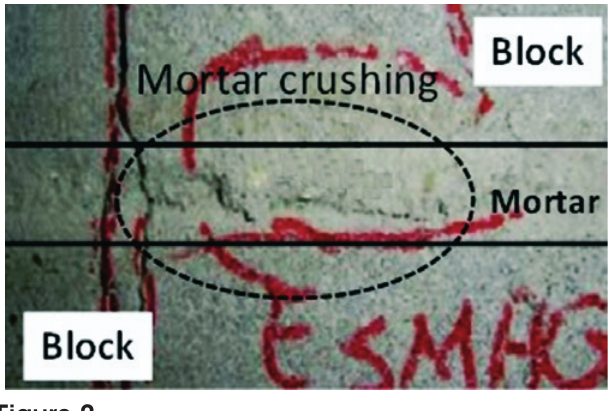
Figure 3 Weak mortar failure model evolution under loading